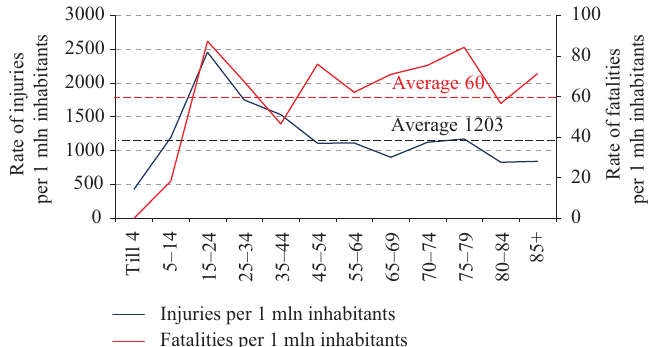
Figure 4. The rate of fatalities and injuries per 1 million inhabitants per age group in Lithuania in